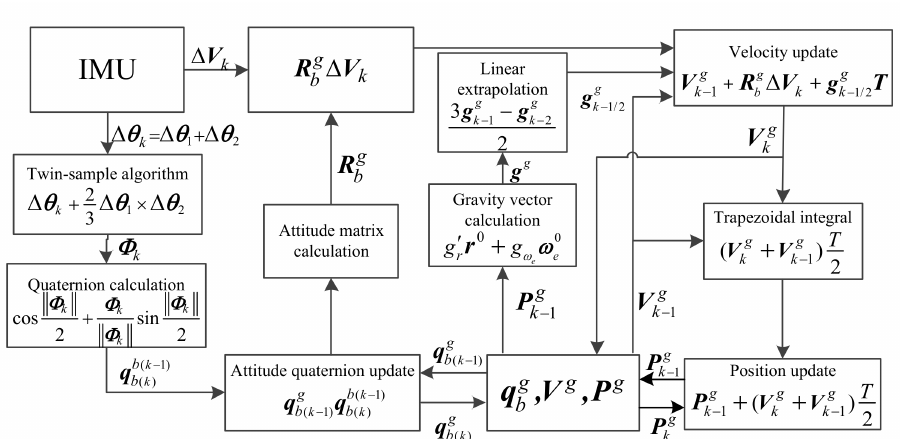
Figure 2. Diagram of the strapdown inertial navigation numerical update algorithm in the LCEF frame.